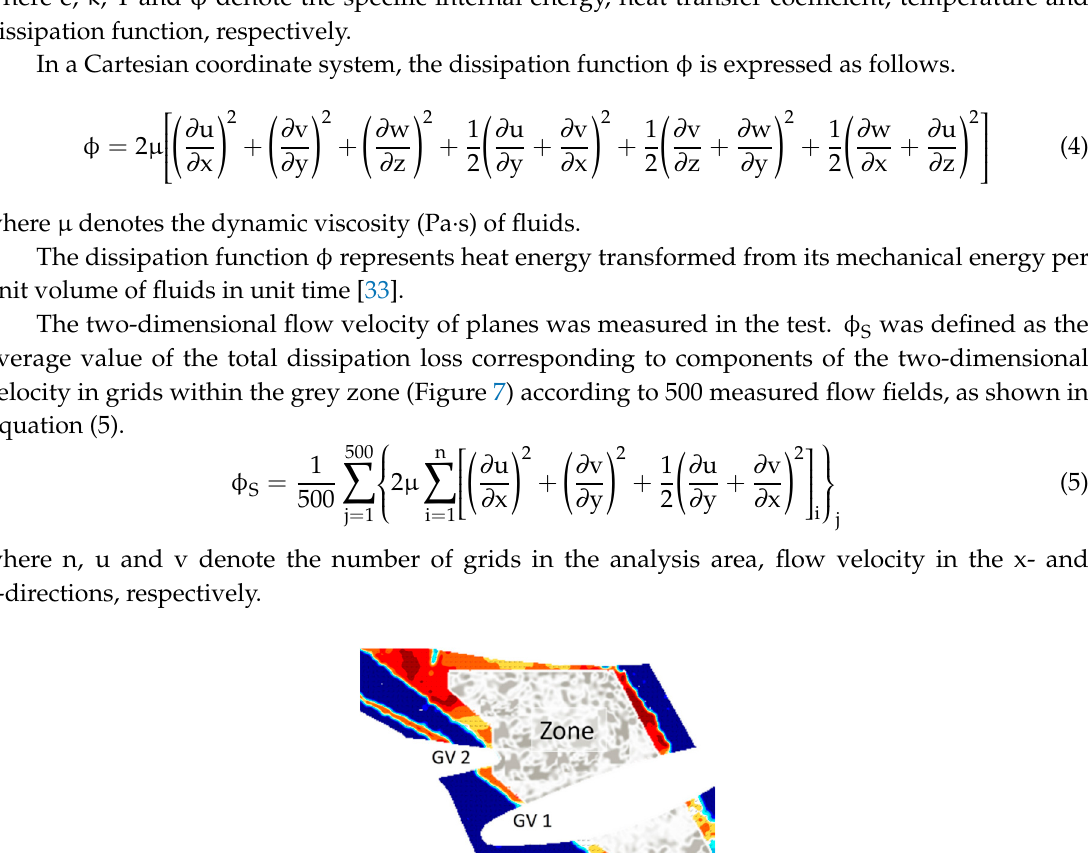
Figure 8. Curves of dissipation ϕ (cid:2903) in the Zone at measurement conditions.